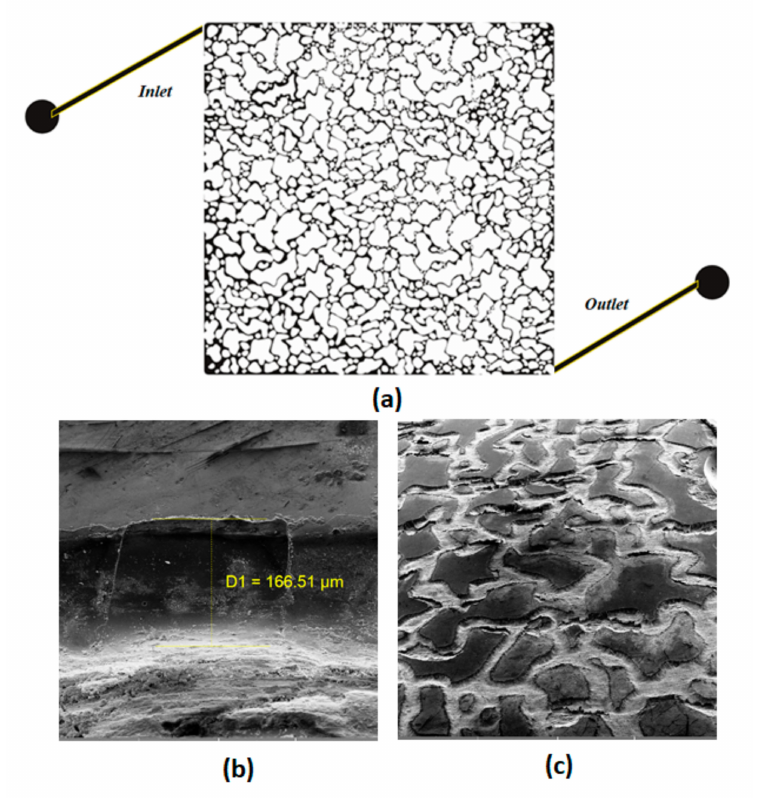
Figure 5. ( a ) The heterogenous network pattern of the investigated micromodel. The SEM images of etched channels: ( b ) top view, ( c ) tilted view.